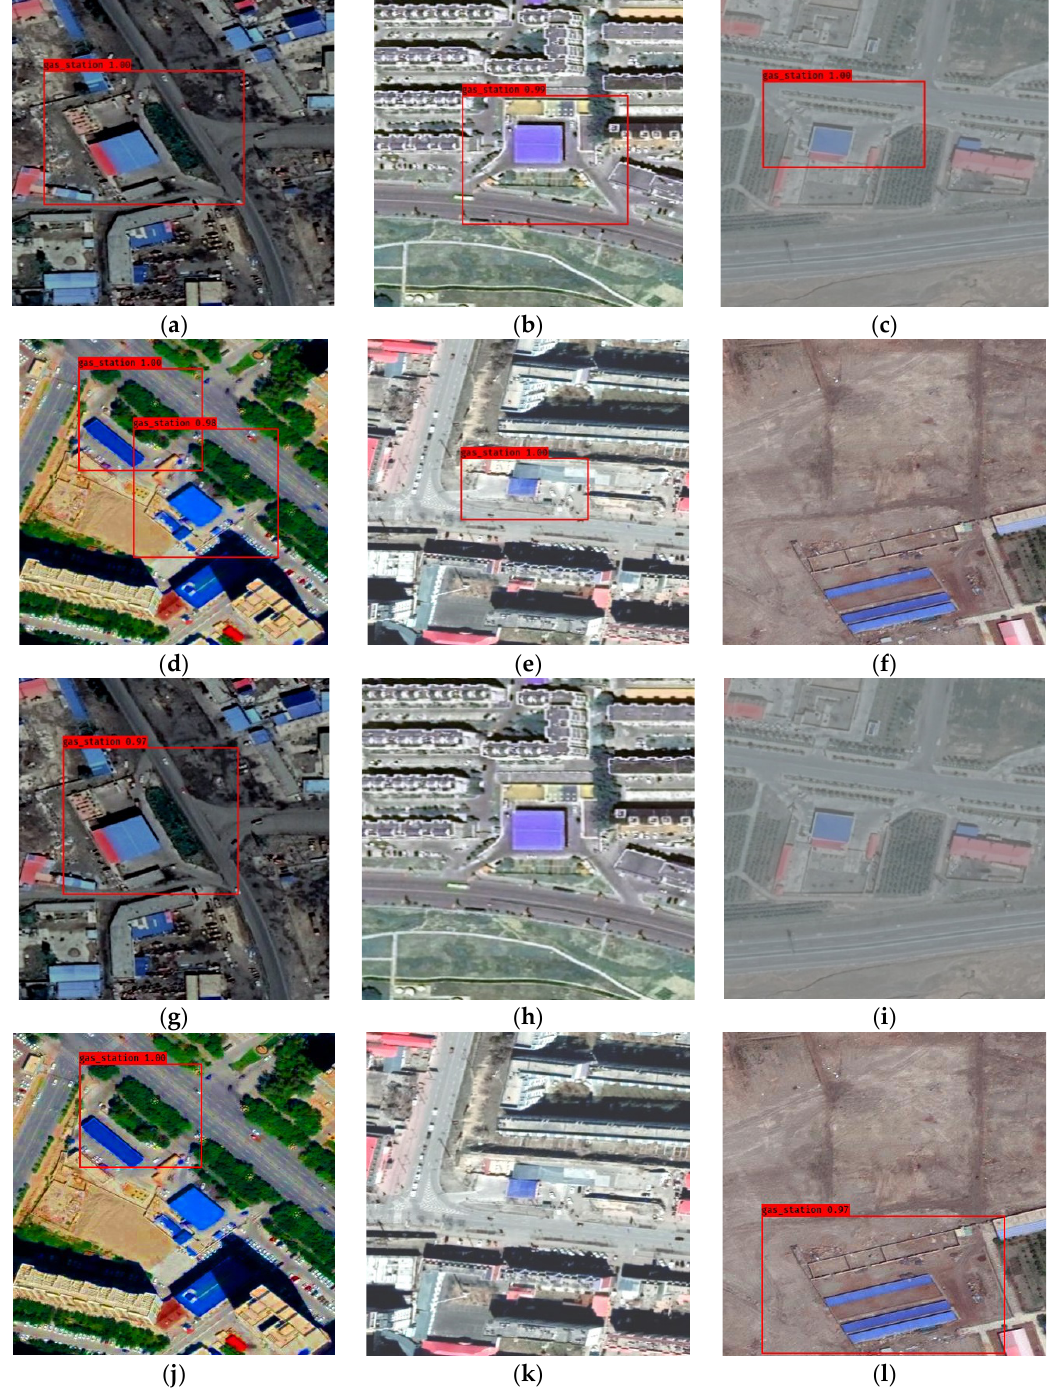
Figure 11. Test results of YOLO-S-CIOU and YOLOv3 on 416 pixels × 416 pixels gas station pictures with different characteristics. ( a – f ) are the test results of YOLO-S-CIOU and ( g – l ) are the test results of